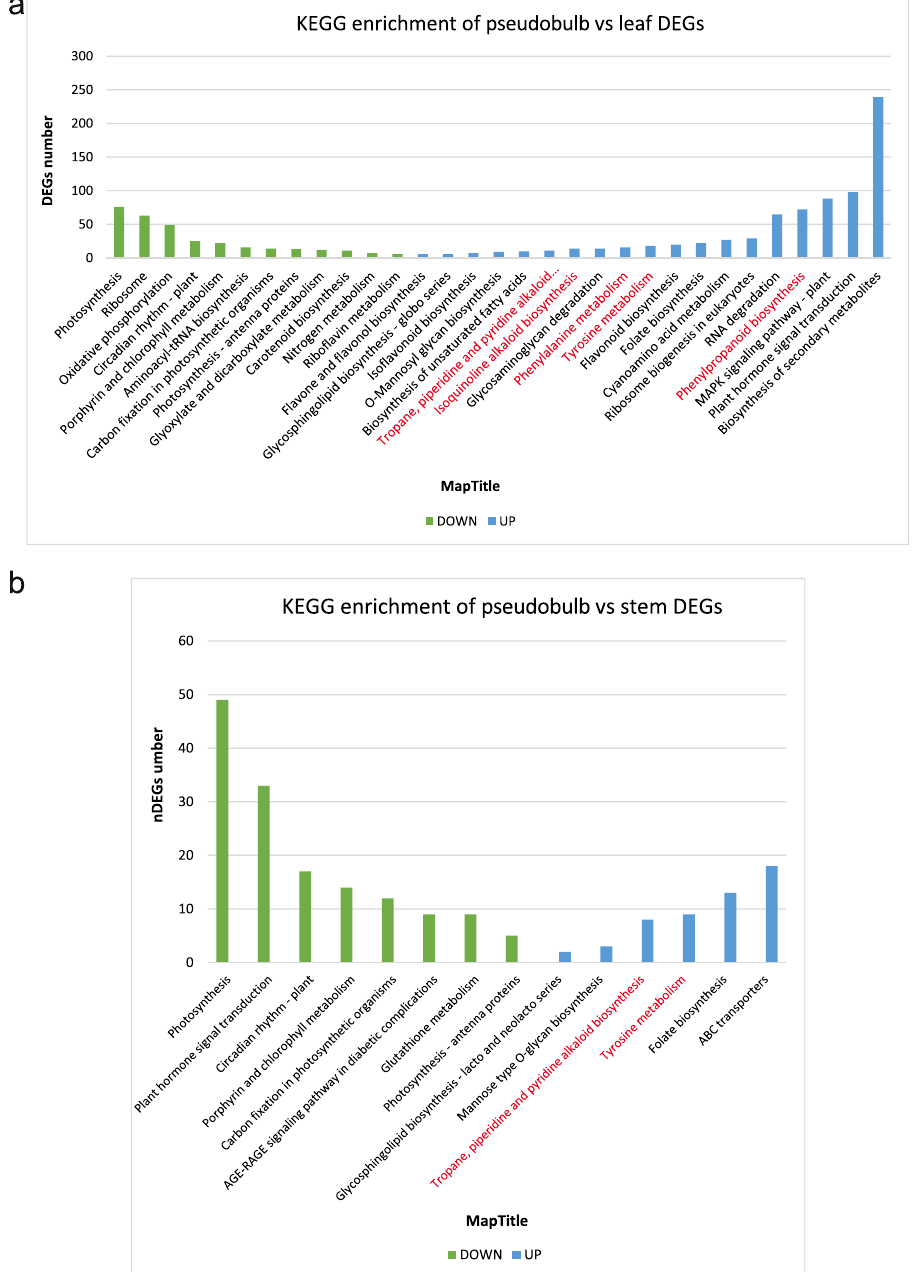
Fig. 7 The KEGG enrichment analysis of DEGs between pseudobulb vs. leaf and pseudobulb vs. stem. a KEGG enrichment analysis of DEGs between pseudobulb and leaf. b KEGG enrichment analysis of DEGs between pseudobulb and stem. Down: green. Up: